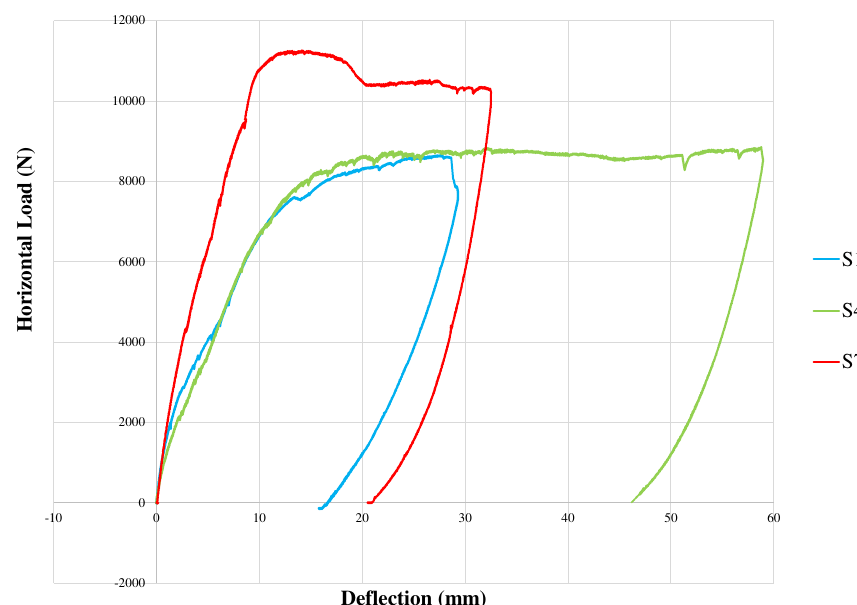
Fig. 8 Load deflection curve for specimens: S1, S4, and